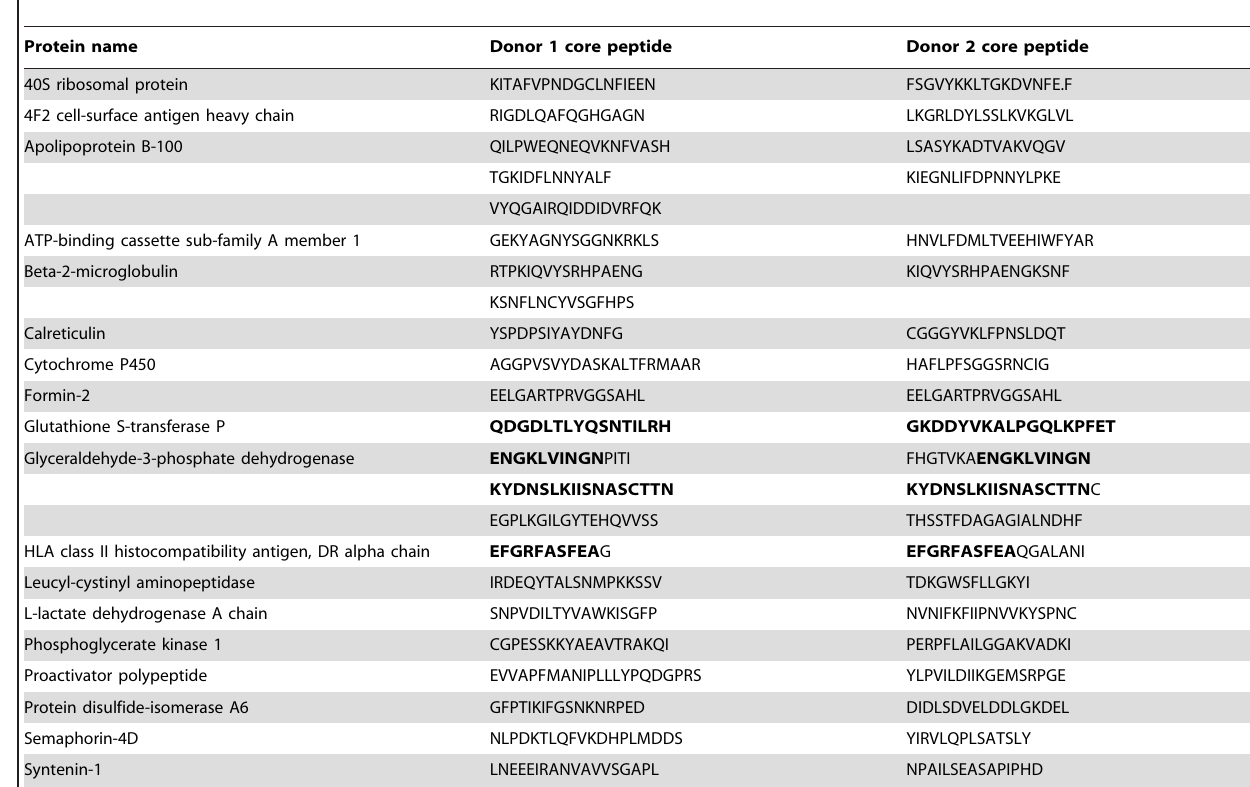
Table 3. Self-peptides identified in two donors with unique class II MHC